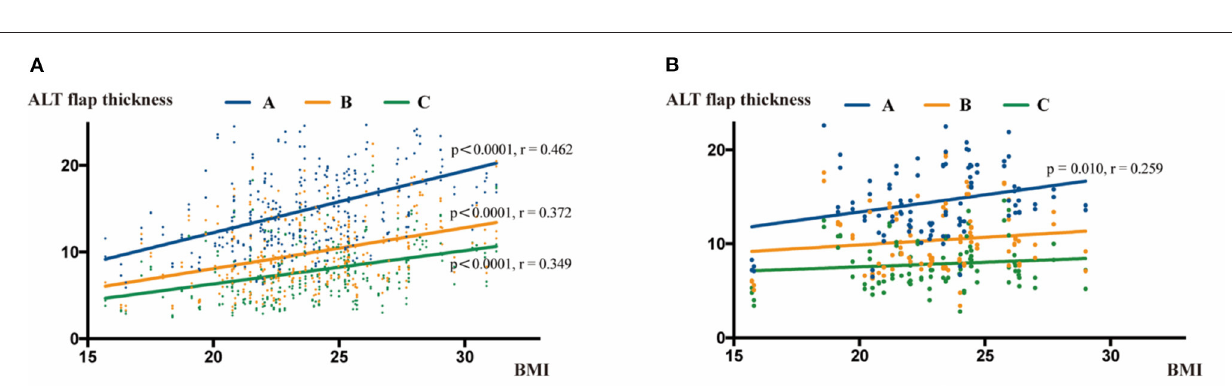
FIGURE 4 | Comparison of CT vs. ultrasound measurement of the ALT flap thickness. (A) In the BMI < 24.0 group, CT and ultrasound measurements showed different results only at point B ( P = 0.04, t test). (B) In the BMI ≥ 24.0 group, CT and ultrasound measurements showed no statistical differences at points A, B, and C.